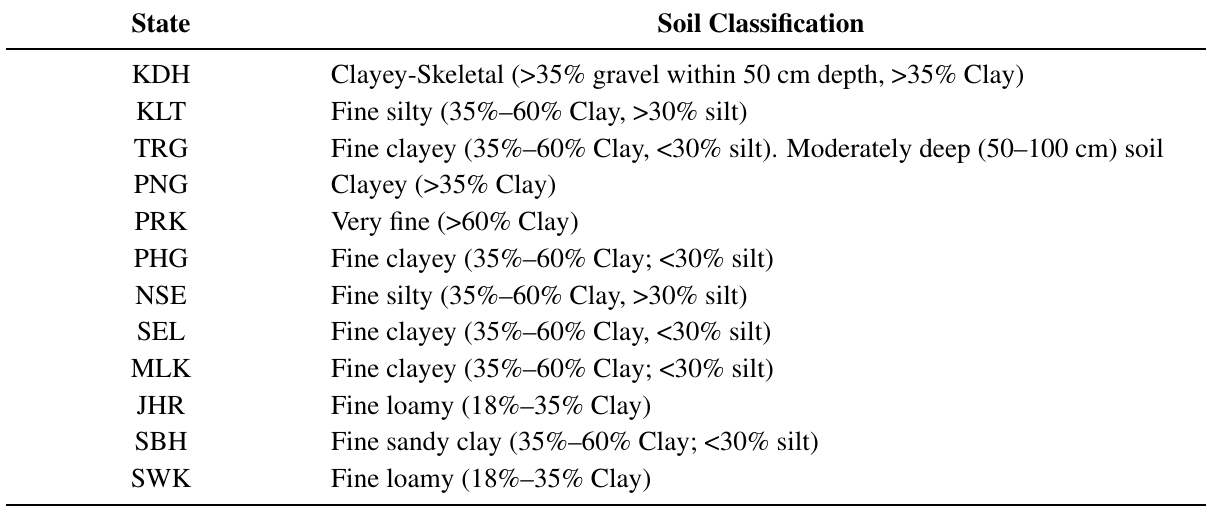
Table 6. Types of soil at various sampling points.